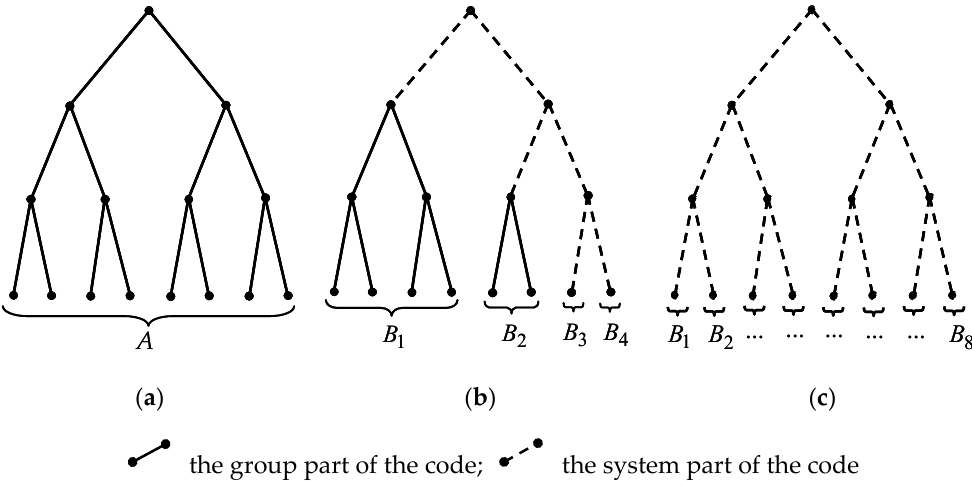
Figure 10. The trees of integrative codes of a discrete system A with the number of elements | A | = 8: ( a ) There is no division of the system into parts ( N = 1 ) ; ( b ) the general case of dividing the system into parts ( 1 < N < | A | ) ; ( c ) the number of parts of the system is equal to the number of its elements ( N = | A | )